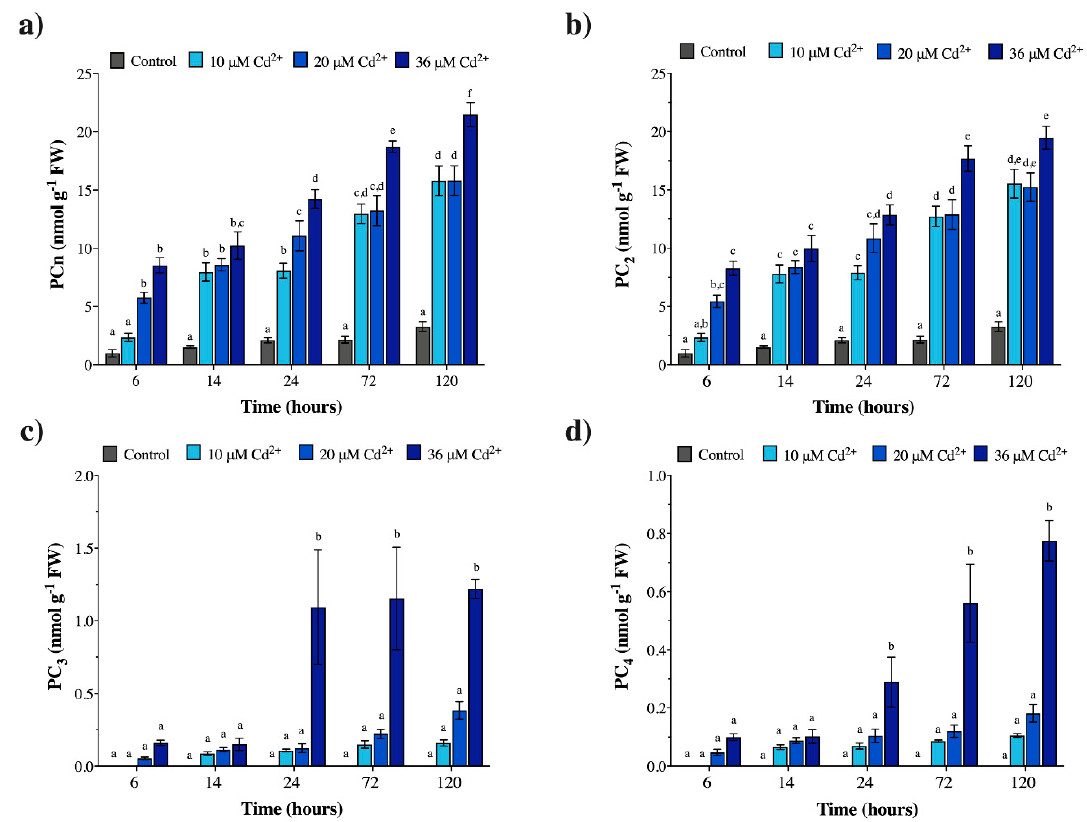
Figure 1. Phytochelatin (PCn) concentrations (nmol g − 1 FW) in M. polymorpha gametophytes exposed in vivo to 0 (control), 10, 20, and 36 µM Cd. Sampling times equal to 6, 14, 24, 72, and 120 h of Cd exposure. ( a ) Total PCn; ( b ) PC 2 ; ( c ) PC 3 ; ( d ) PC 4 . Values are the mean ± SE; n = 5. Different letters indicate significant differences at p < 0.05 (two-way ANOVA, followed by Tukey's post-hoc test).